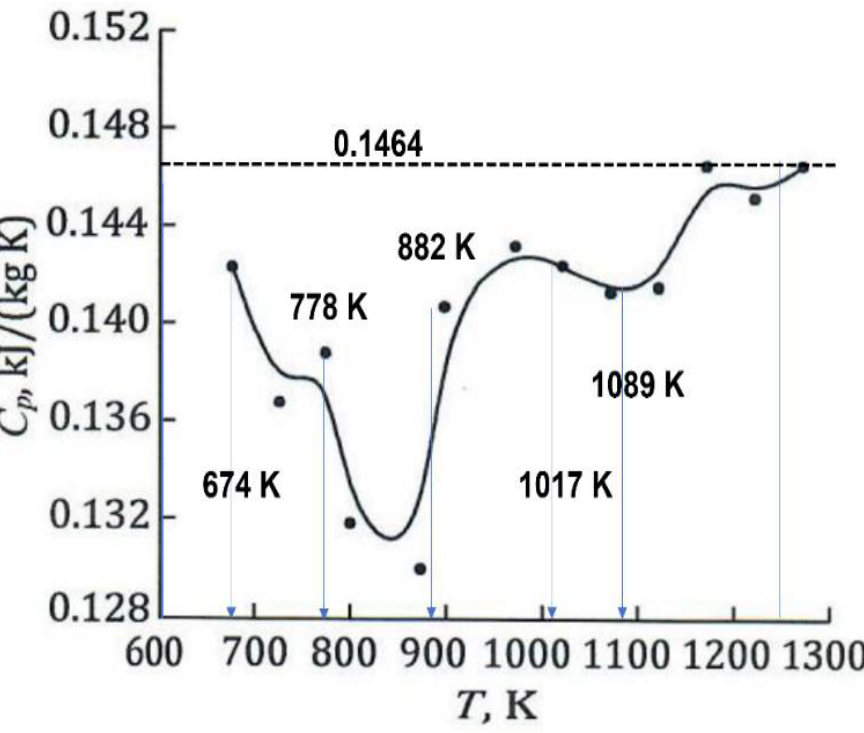
Figure 4. Specific heat of bismuth above T m . Reproduced from [62] with permission of Springer Ed. The line C p = 0.1464 KJ/ (Kg K) leading to the value of C p at T m = 505 K is added. The specific heat is constant from T m to 2 T m in the absence of relaxed enthalpy. T g = 674 K for Δε = 0.23838 + 0.09401 = 0.3324, T g = 778 K for Δε = (0.42908 = 0.1907 + 0.23838), T g = 882 K for Δε = (0.429 + 0.23838 + 0.09456 = 0.761), T g = 1017 K for Δε = 0.8675, T g = 1089 K for Δε = 1.